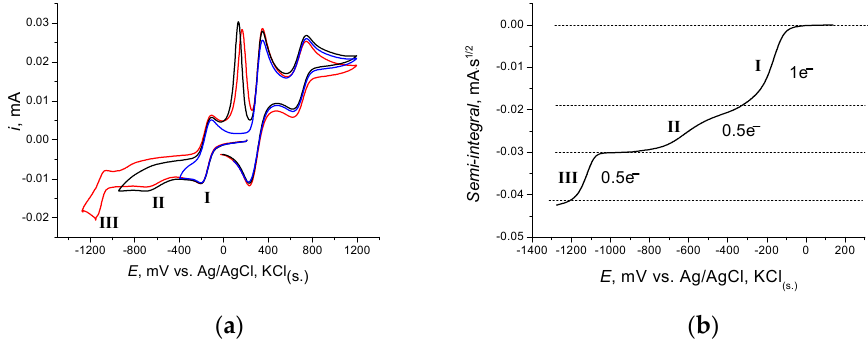
Figure 6. ( a ) Voltammogram of I (2.1 mM in 0.05 M n -Bu 4 NBF 4 in MeCN, 50 mV/s, Pt); ( b ) semi-integral transformation of the cathode part of the voltammogram shown in Figure 6a.